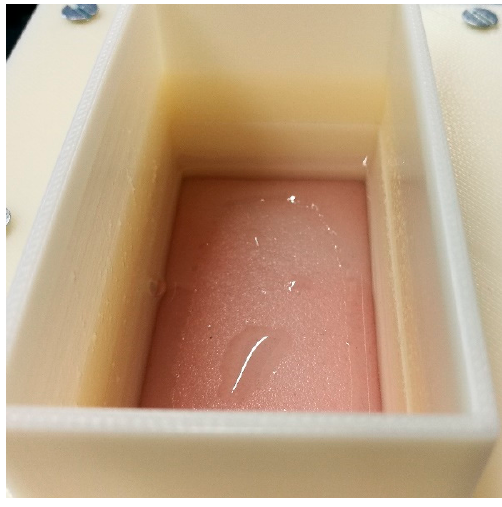
Figure 13. Water residue on top of the CAF1 filter after filtration of 500 mL emulsion.